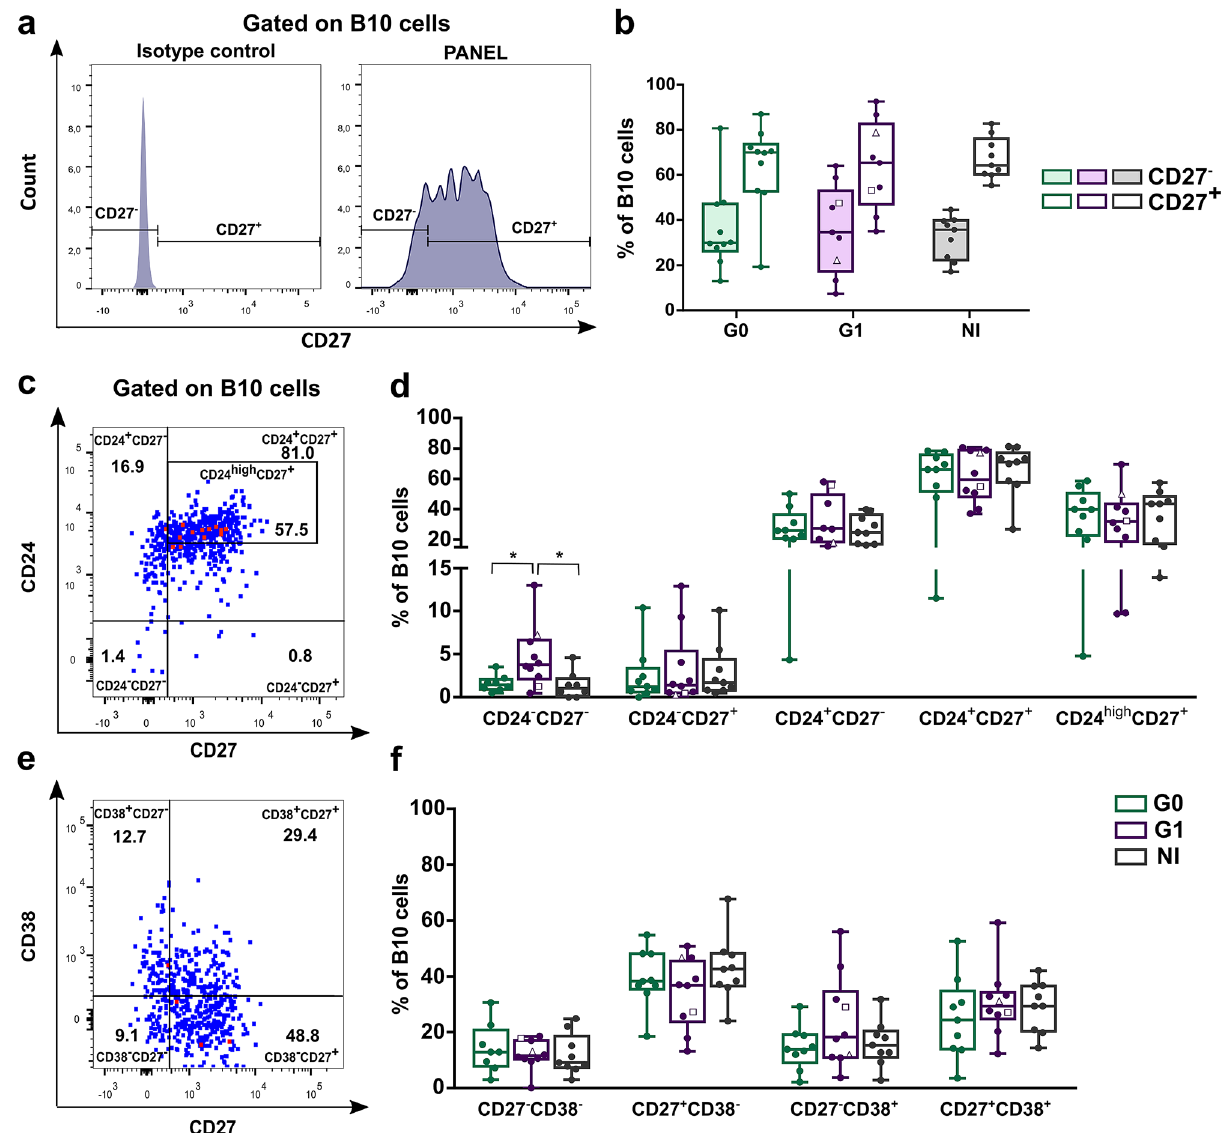
Figure 4. Phenotypic distribution of B10 cells according to CD27, CD27-CD24 and CD27-CD38 expression in CCD patients and non-infected donors. ( a ) Histograms showing the gating strategy used to determine CD27 − (naïve) and CD27 + (memory) populations within B10 cells in PIB stimulated PBMC. One representative non- infected donor is illustrated. ( b ) Frequency of CD27 − and CD27 + B10 cells in CCD patients (G0, G1) and non- infected donors (NI). ( c , d ) Representative dot plots from a non-infected donor showing gating strategy used to determine the subsets within total B10 cells based on the combine expression of CD24 and CD27 or CD27 and CD38 in PIB stimulated PBMC. ( e , f ) Frequency of B10 cell subsets within CD24-CD27 and CD27-CD38 subpopulations in CCD patients (G0 G1) and non-infected donors (NI). Each dot represents data from one subject; inside G1 group, solid circles correspond to K1 patients, hollow triangle to K2 patient and hollow square to K3 patient. Boxes and whiskers show median value and interquartile range. Statistically significant differences among groups are indicated ( *p <